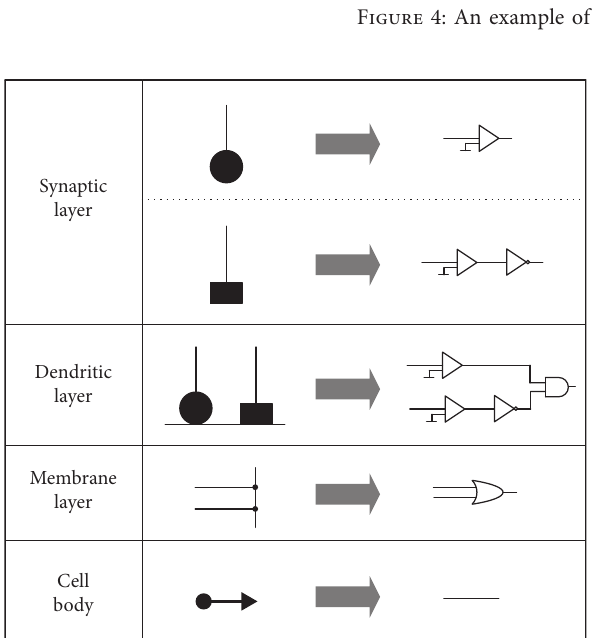
Figure 5: An example of the logical circuit transformation